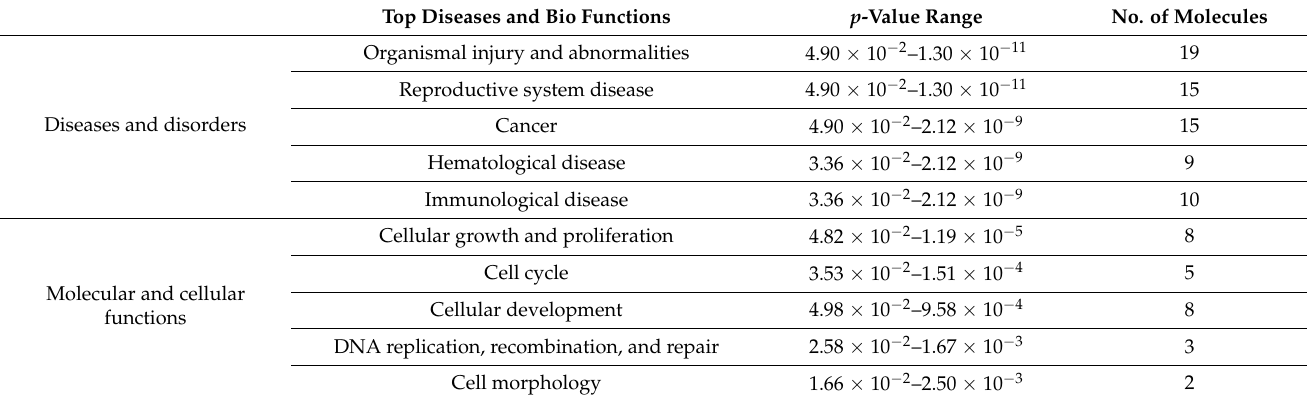
Table 3. Top diseases and bio functions related to upregulated miRNA target genes.